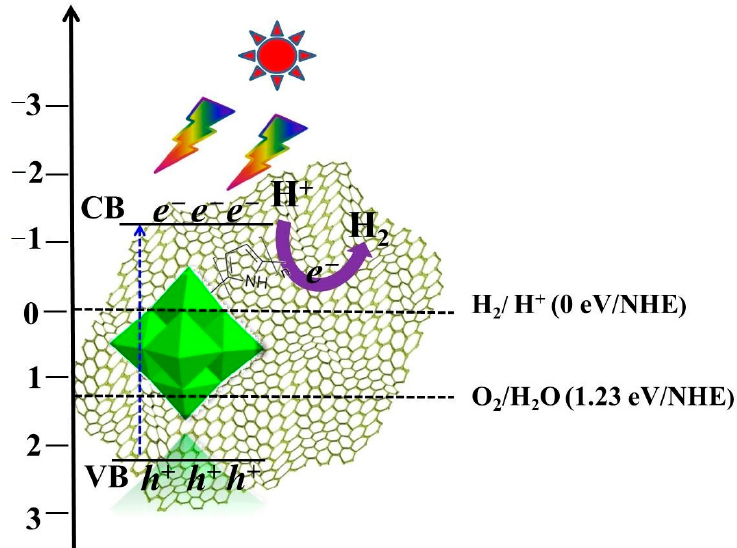
Figure 10. The proposed photocatalytic hydrogen production mechanism of Nb 6 /PPy-RGO-0.25 (NHE = normal hydrogen electrode).